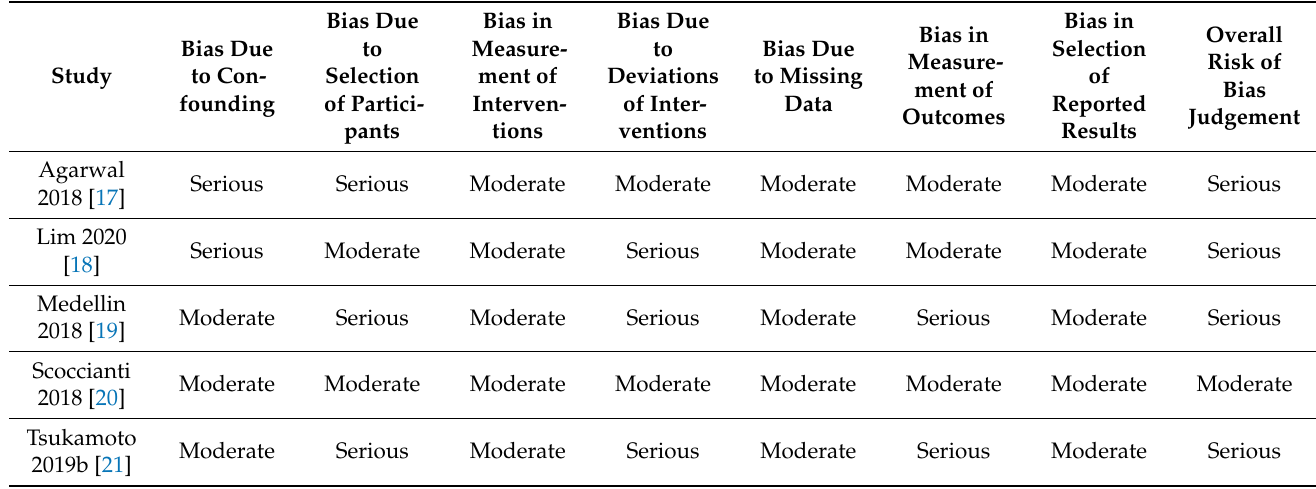
Table 2. Risk of Bias in non-randomized studies of interventions (ROBIN-I) evaluation of included non-randomized studies.